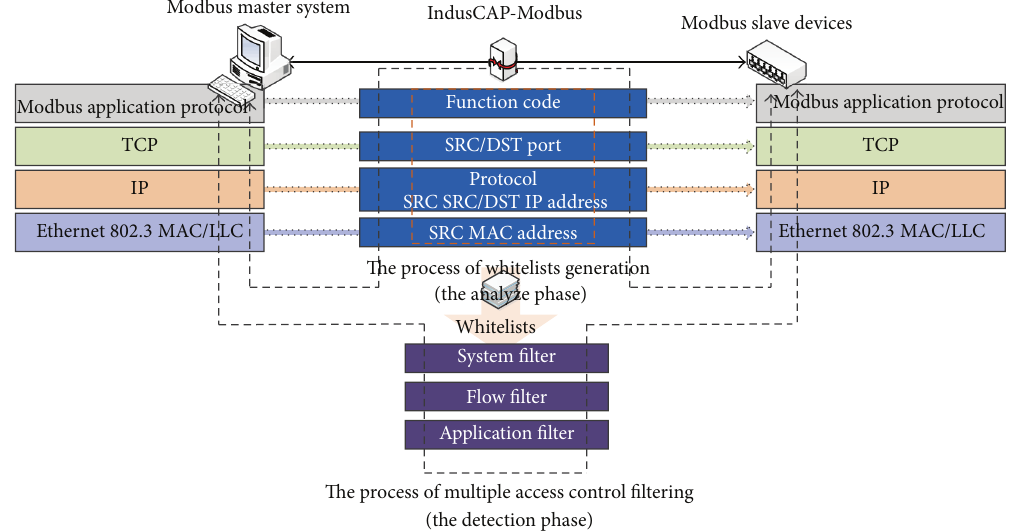
Figure 3: The packet processing flows of the IndusCAP-Gate system.